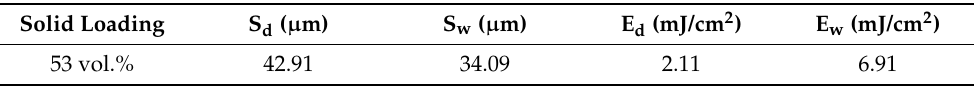
Table 2. Sensitivities (S d and S w ) and critical energy doses (E d and E w ) of the mica slurry (solid loading = 53